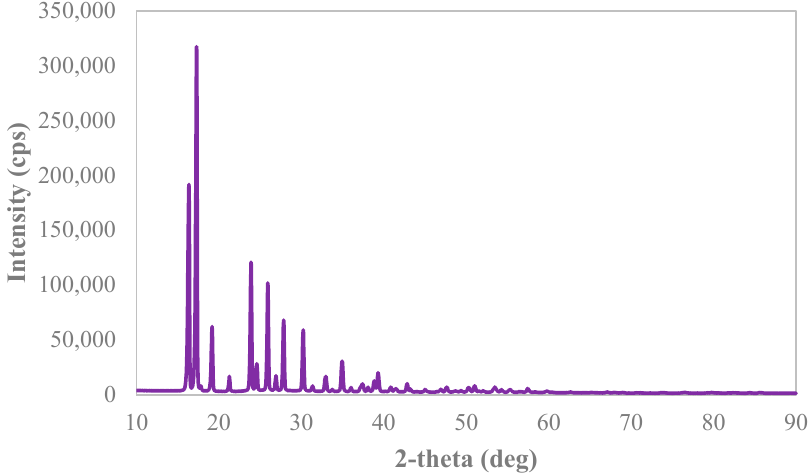
Figure A8. X-ray diffraction spectra of benzoic acid crystallized in neat